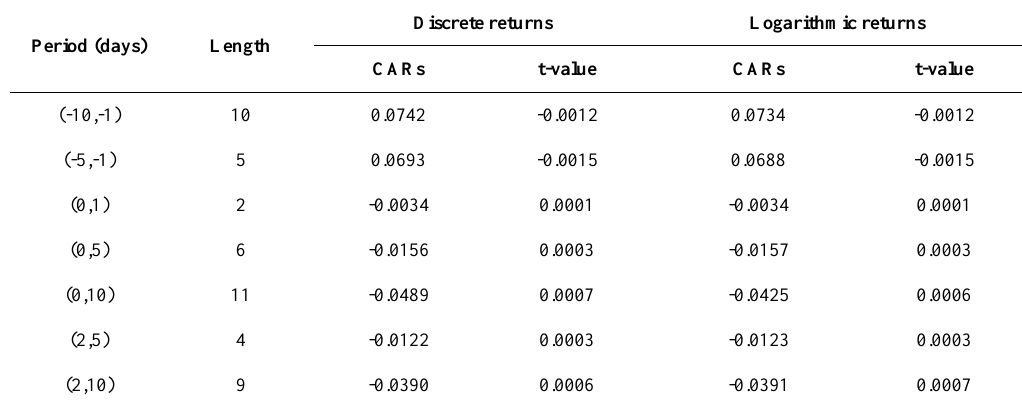
Table3. Cumulative abnormal returns (CARs) & t-values of stocks using both discrete and logarithmic returns for one